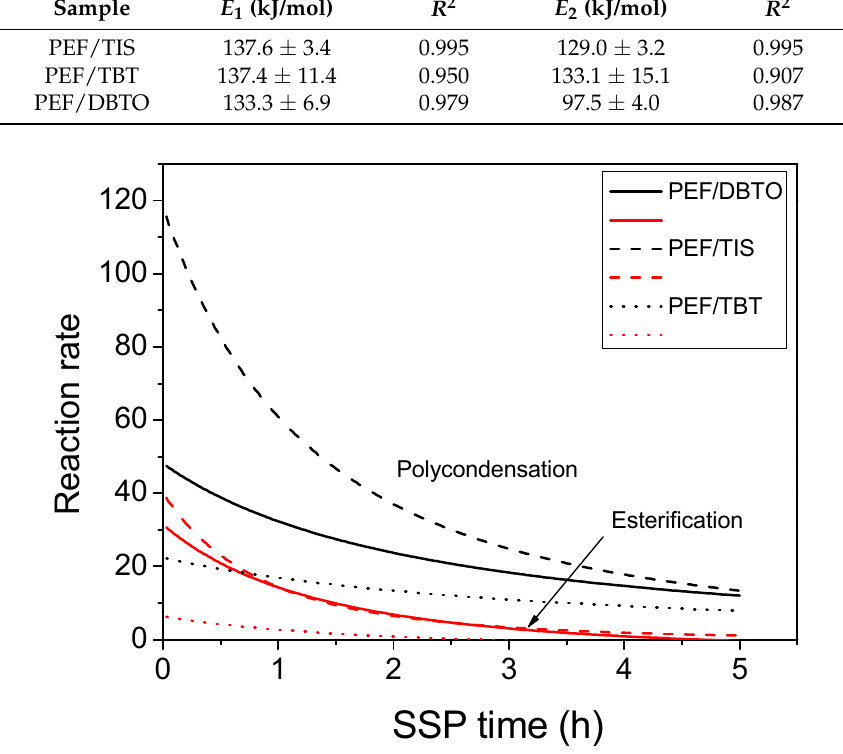
Figure 6. Variation of the polycondensation and esterification reaction rates with SSP time estimated during SSP of PEF/TIS, PEF/TBT, and PEF/DBTO at 200 °C.